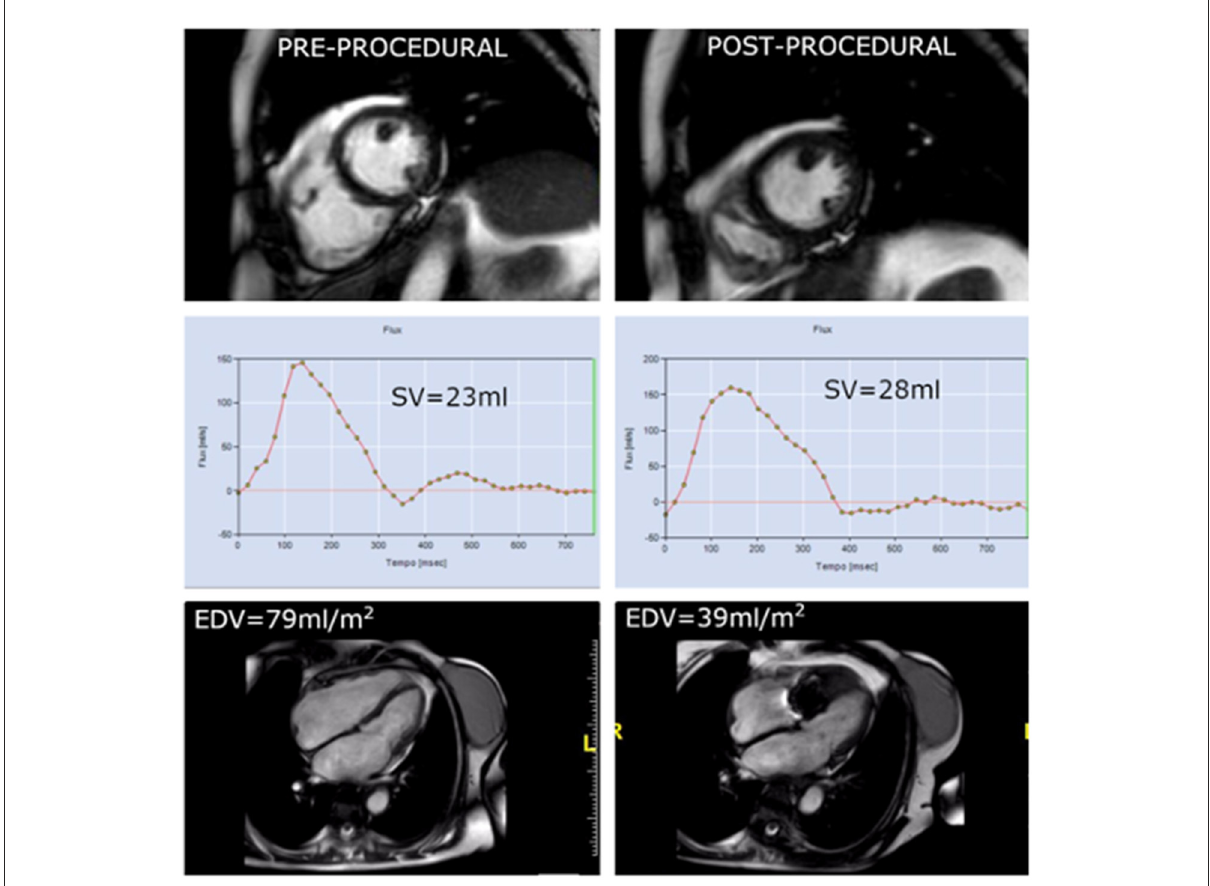
FIGURE2 In the same patient showing early annulus size reduction, the comparison between pre-procedural CMR ( left column ) and immediately after procedure ( right column ) depicts a significant reduction in EDV as consequence of acute remodeling the day after the procedure. Phase contrast imaging shows a slight increase in absolute forward stroke due to reduction in regurgitant